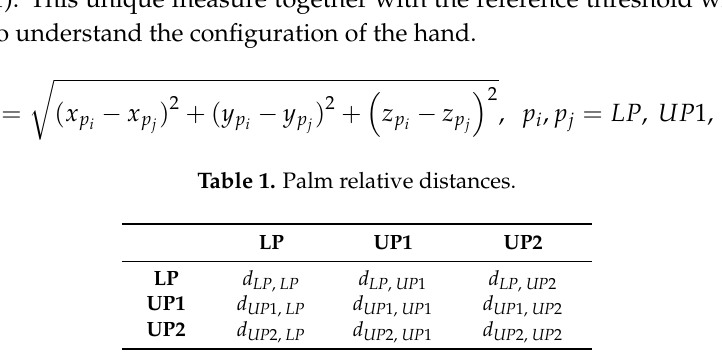
Table 1. Palm relative distances.